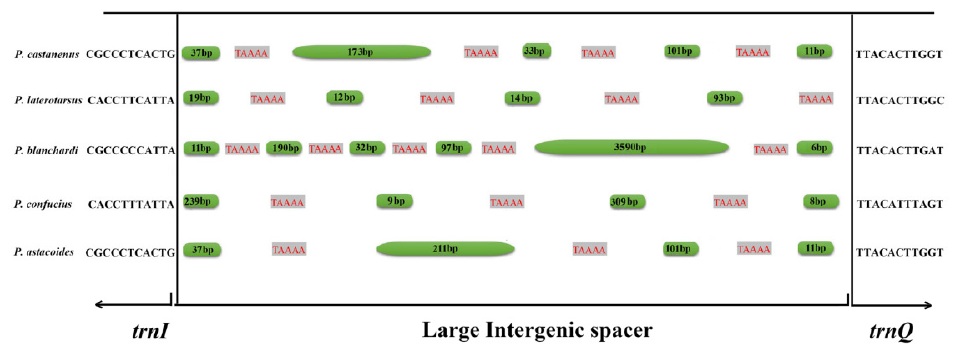
Figure 4. Composition of the large intergenic spacer between trnI and trnQ among the five sequenced mitochondrial genomes of Prosopocoilus in the present study. The grey-shaded region represents the short sequence repeat (TAAAA). The green-shaded region represents the size of the spacers between the short sequence (TAAAA) repeats.